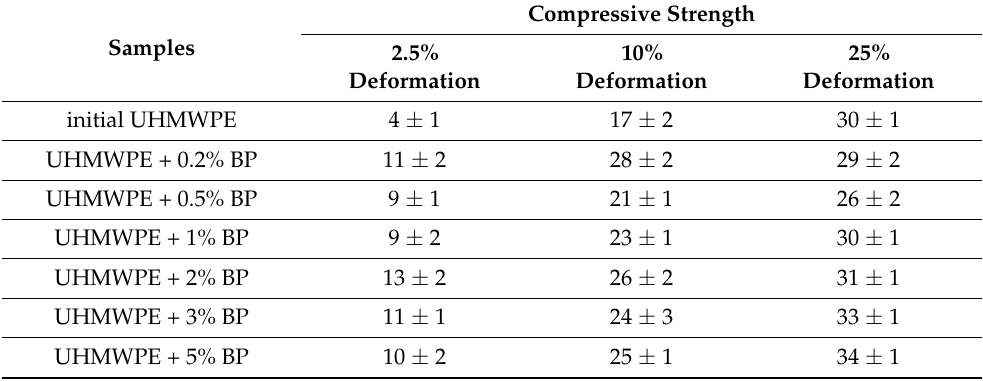
Table 4. Melting point, melting enthalpy, and degree of crystallinity of UHMWPE and